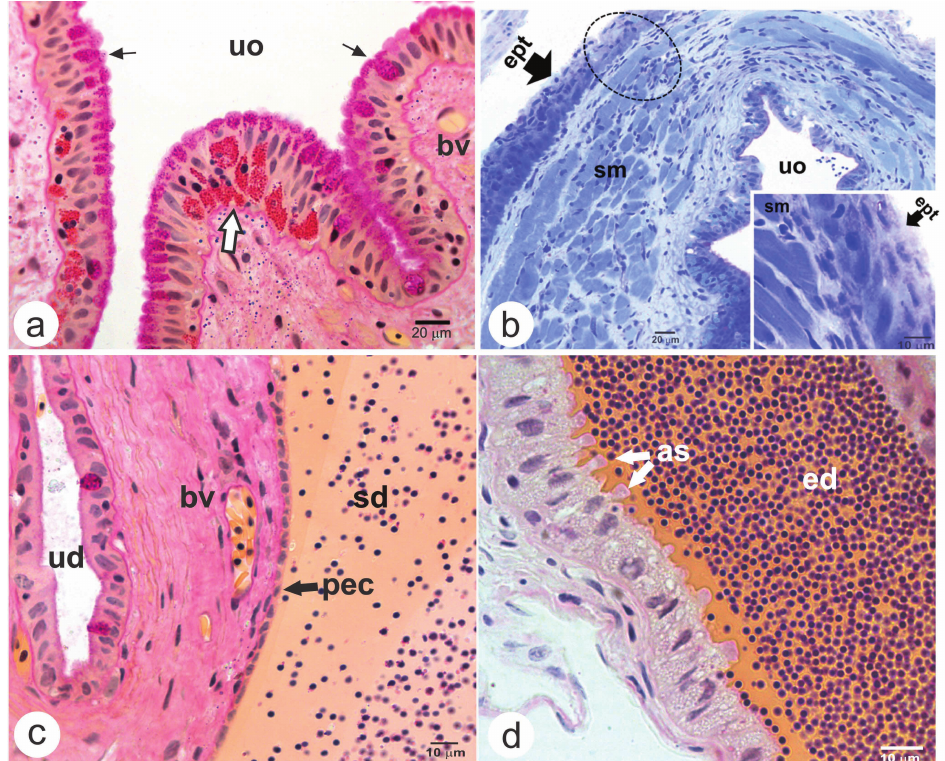
Fig. 2. Histological characteristics of the genital duct in male Astyanax altiparanae. a) Urogenital opening (uo) highlighting the clusters of neutral polysaccharides (white arrow), the mucous-producing cells and the brush border (thin arrow); b) detail of the striated muscle (sm) that surround the urogenital opening and the stratified skin (ept) that involve the urogenital papilla; c) sperm duct (sd) highlighting the pavimentous epithelial cells (pec) and seminal fluid labelled in orange; d) efferent duct (ed) with secretory cells with possible apocrine activity (as). Abbreviations and symbols: bv = blood vessel; ept = squamous stratified epithelium; ud = urinary duct. Label: a, c-d = Metanil-Yellow/PAS/Harris Haematoxylin; b = Toluidine